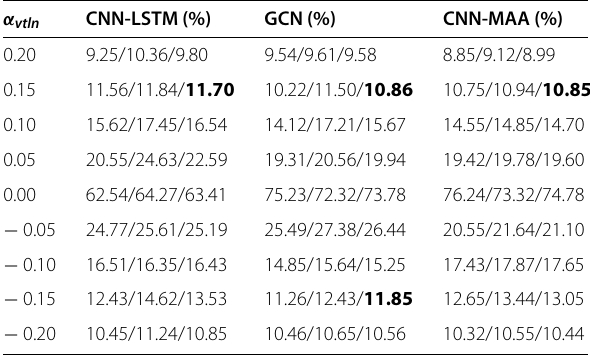
which is less than 1, and θ n ∈ [ 0, π ] is the offset phase. The pipeline of the McAdams transformation approach is shown in Fig.